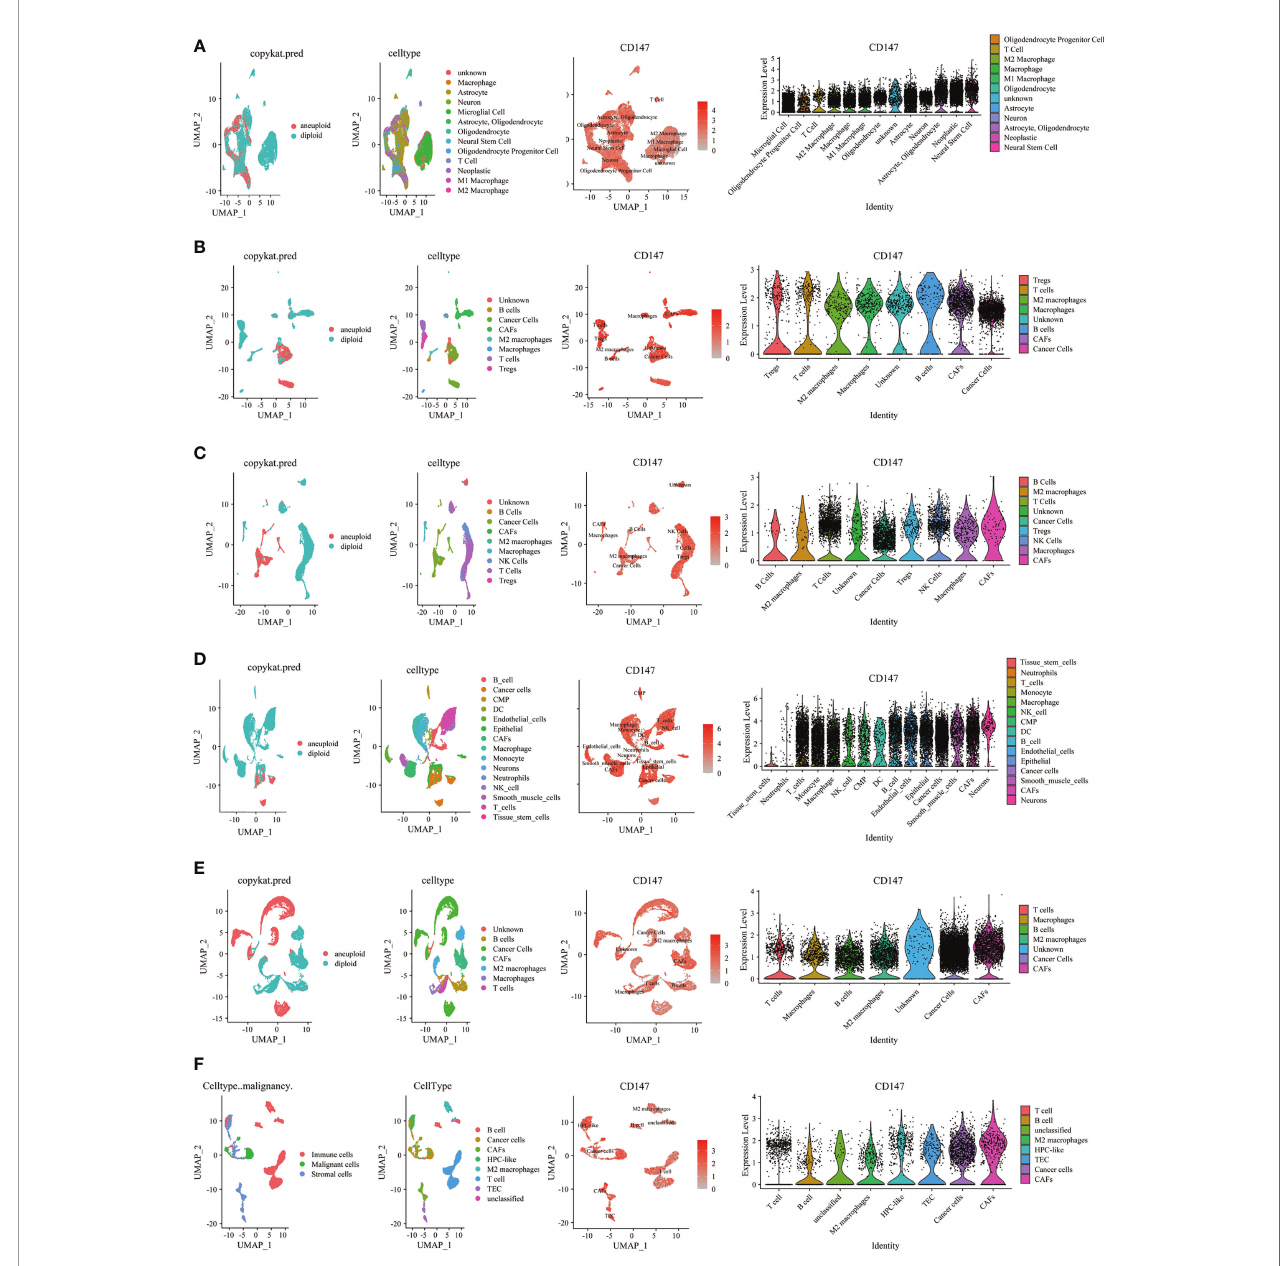
FIGURE 7 | Single cell sequencing analyzing CD147 co-expression on tumor and stromal cells in pan-cancer. The expression levels of CD147 in tumor and stromal cells in GBM (A) , HNSC (B) , KIRC (C) , LUAD (D) , PRAD (E) , CHOL (F)